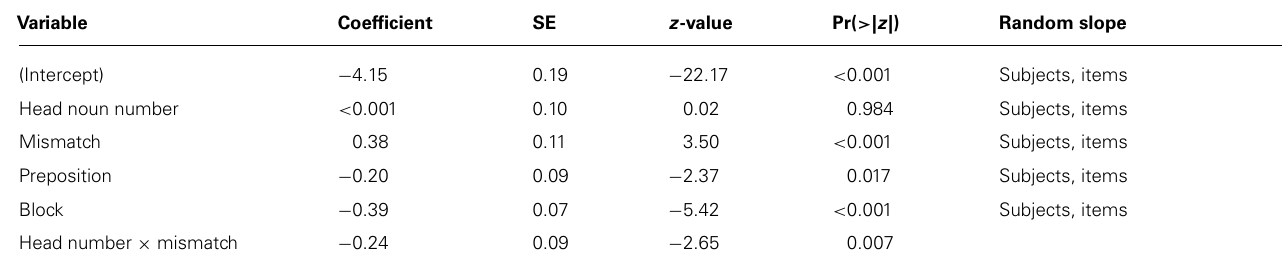
Table 5 | Logistic mixed-effects model predicting agreement errors in Experiment